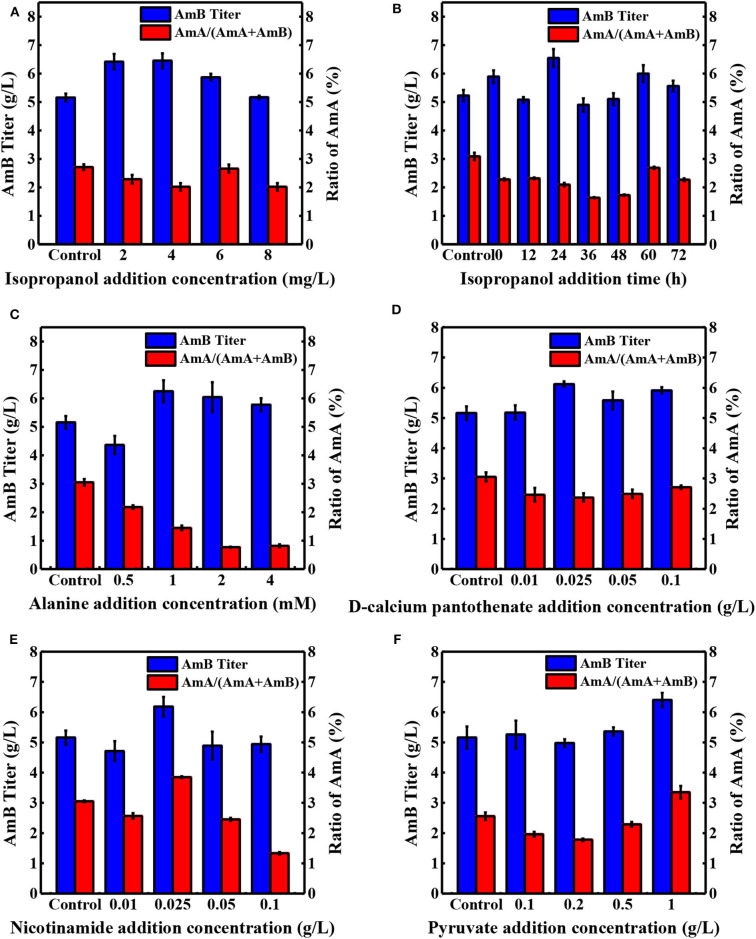
Effects of different concentrations of additives on the production of AmA and AmB. (A) Isopropanol, (C) alanine, (D) D-calcium pantothenate, (E) nicotinamide, and (F) pyruvate at 108 h. (B) The optimal addition time was determined with isopropanol. The blue and red bar charts represent the concentration of AmB in the sample and the proportion of by-product AmA in the total amount of AmA and AmB, respectively. Each value is calculated from at least triplicate cultures.